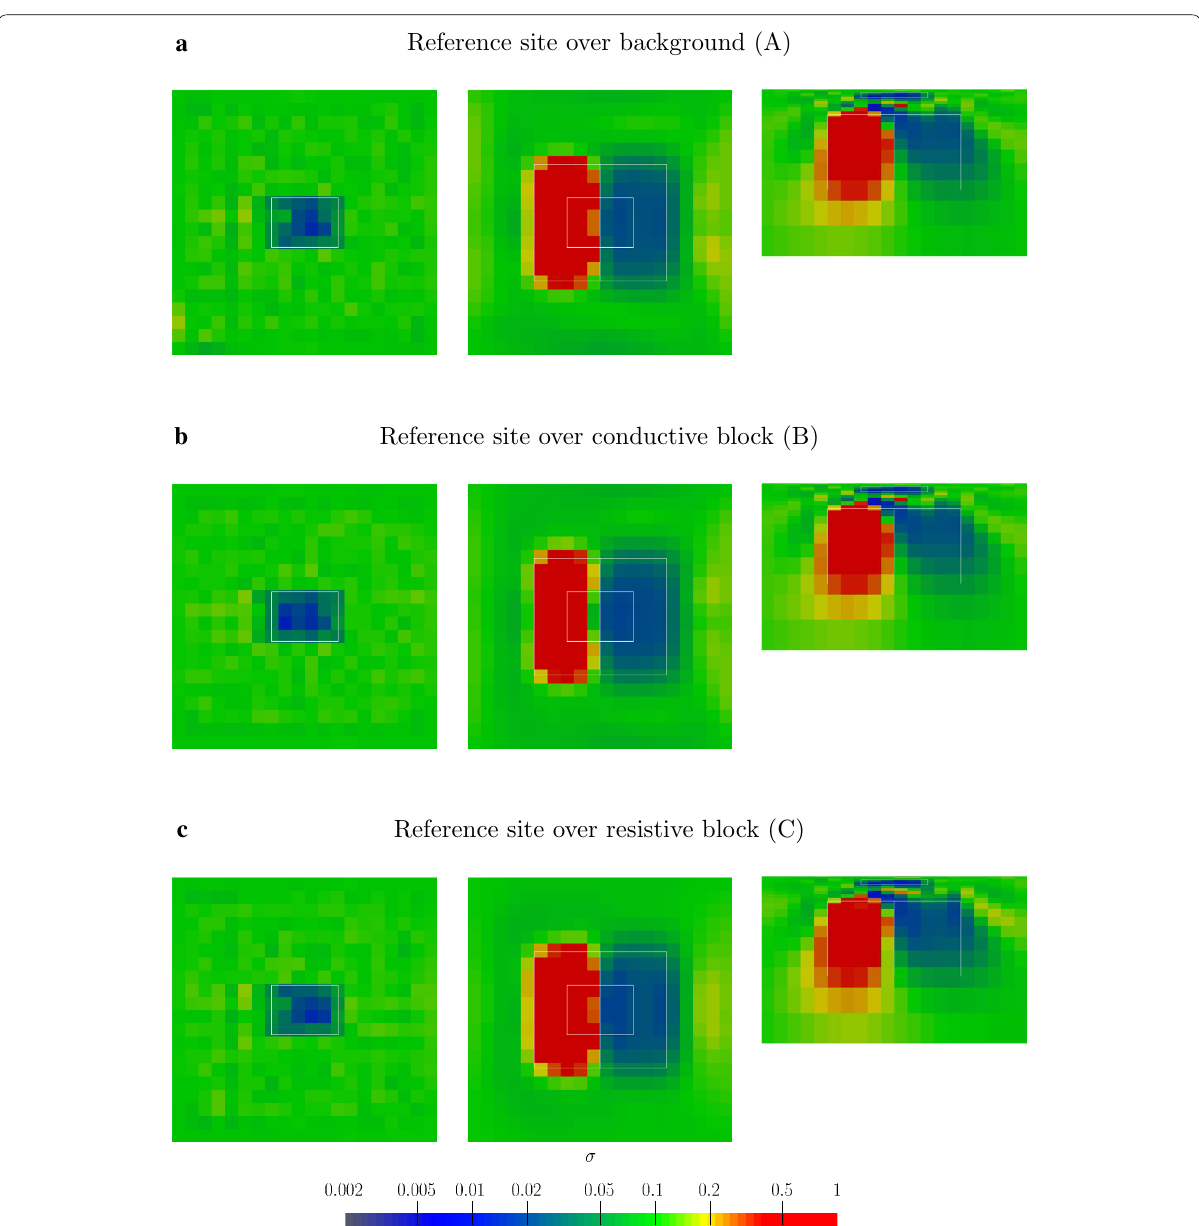
Fig. 4 Model recovered by inversion of inter-site impedance tensor Q . The results are shown through the same cross sections as in upper plots of Fig. 1. From top to bottom are the results for different location of the reference site. Specifically, top, middle and bottom rows show the results for the cases when reference sites was placed in 1-D environment, above deep conductive, and deep resistive block,